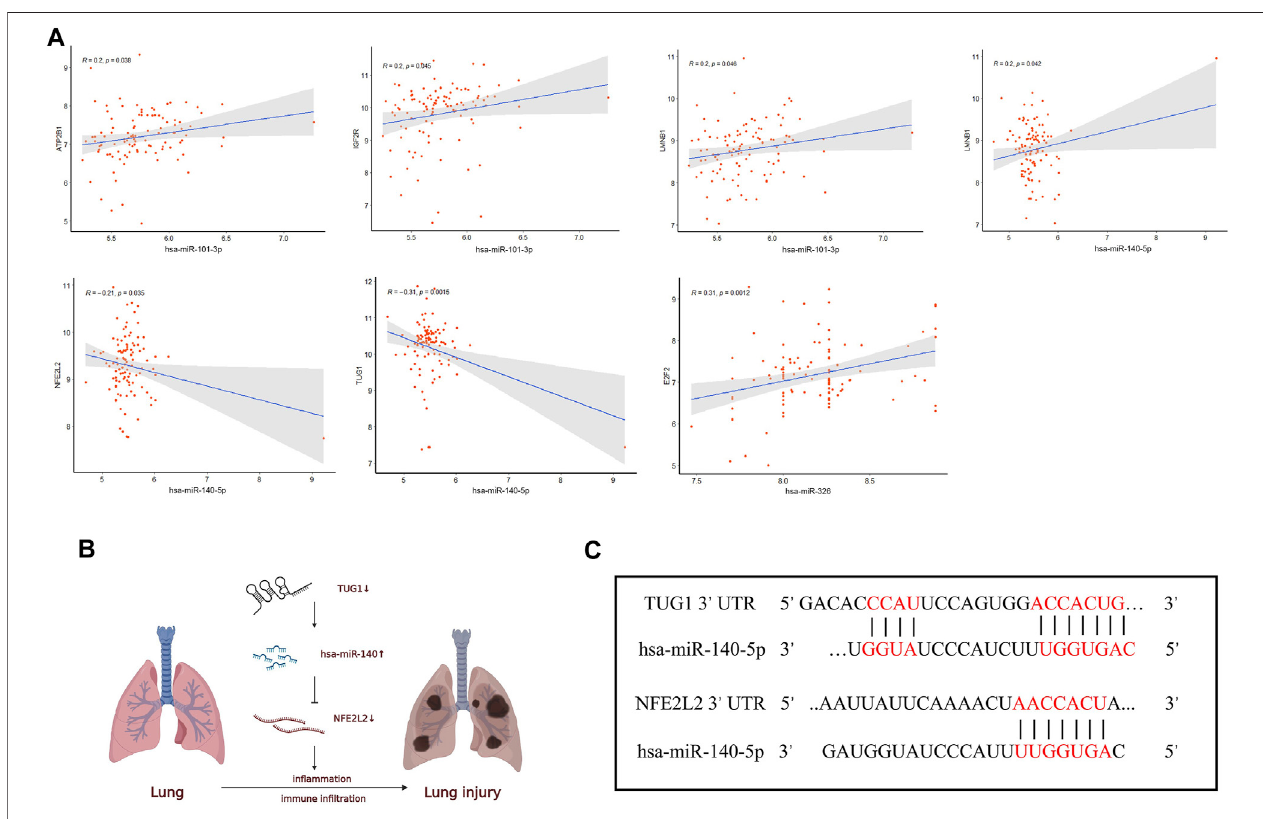
FIGURE 7 | Correlation analysis of the ceRNA network. (A) The correlation analysis among the hub genes in the ceRNA network. (B) Schematic model of the ceRNA network. (C) Binding sites of miR-140-5p to the 3 ′ UTRs region of TUG1 and NFE2L2 predicted by TargetScan and DIANA.